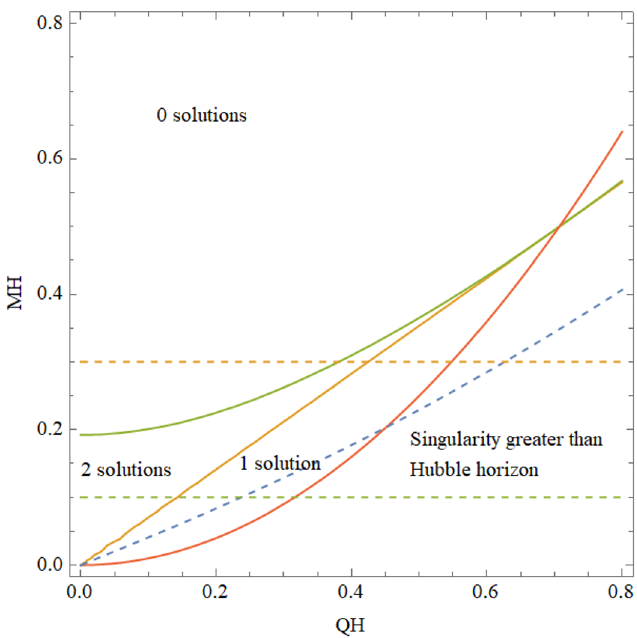
Figure 1 . Number of horizons of the α = 1 de Sitter black hole as a function of MH and QH . √ The green curve represents HD , the yellow one the limit 2 MH = Qe αφ 0 H , and the red one 0 . Dotted lines are for intermediate steps and discussions in the D 2 H 2 = 1 4